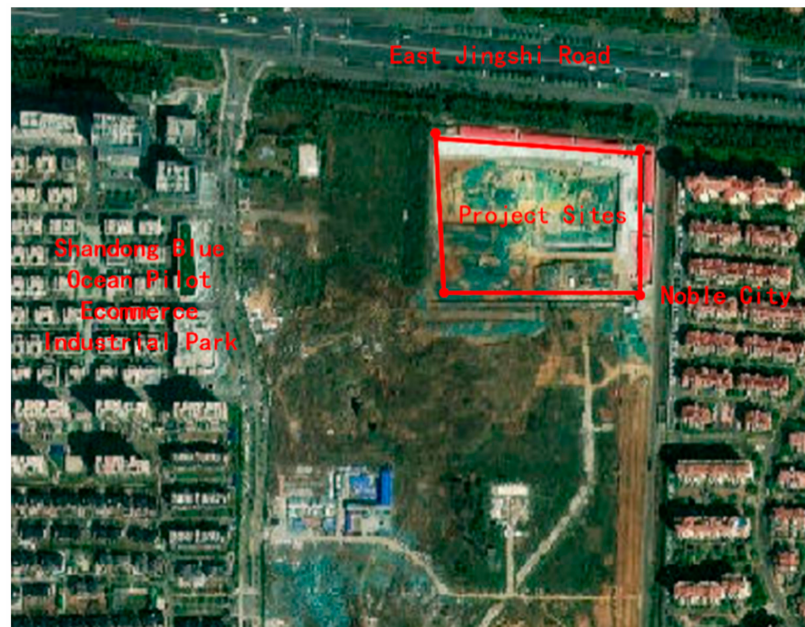
Figure 1. Location map of the study area.